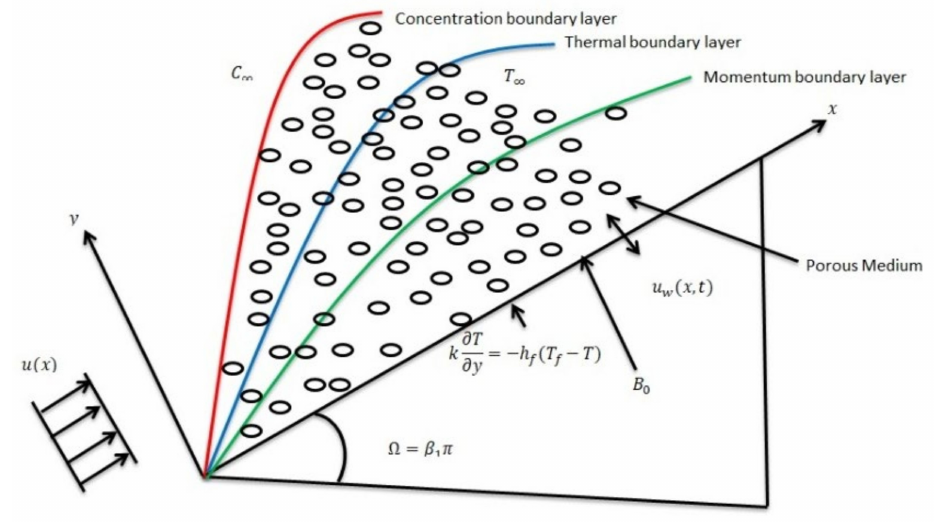
Figure 1. Geometry of the